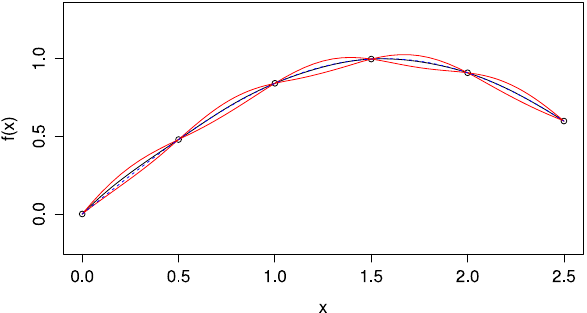
Figure 4. One-dimensional example of an emulator. The points rep- resent the six evaluations of f ( x ) , the black line is the emulator’s prediction, and the red lines give 2 standard deviations. The blue dashed line is the true value of f ( x )